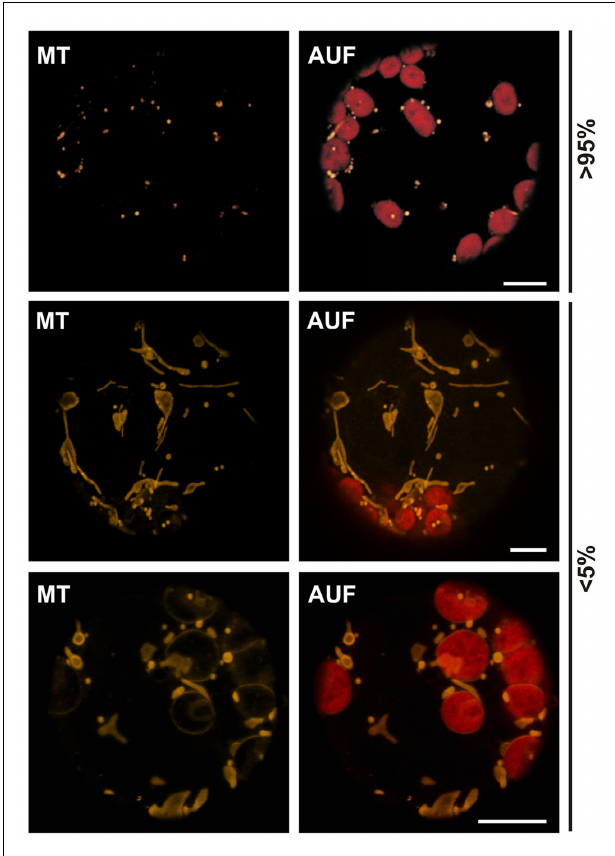
FIGURE 2 | Morphological differences of plant mitochondria. Untransfected wild type protoplasts from A. thaliana stained with MitoTracker reveal the different morphologies of plant mitochondria. Images are single optical sections. MitoTracker staining (MT), chlorophyll autofluorescence (AUF). Scale bars represent 10 μ m.